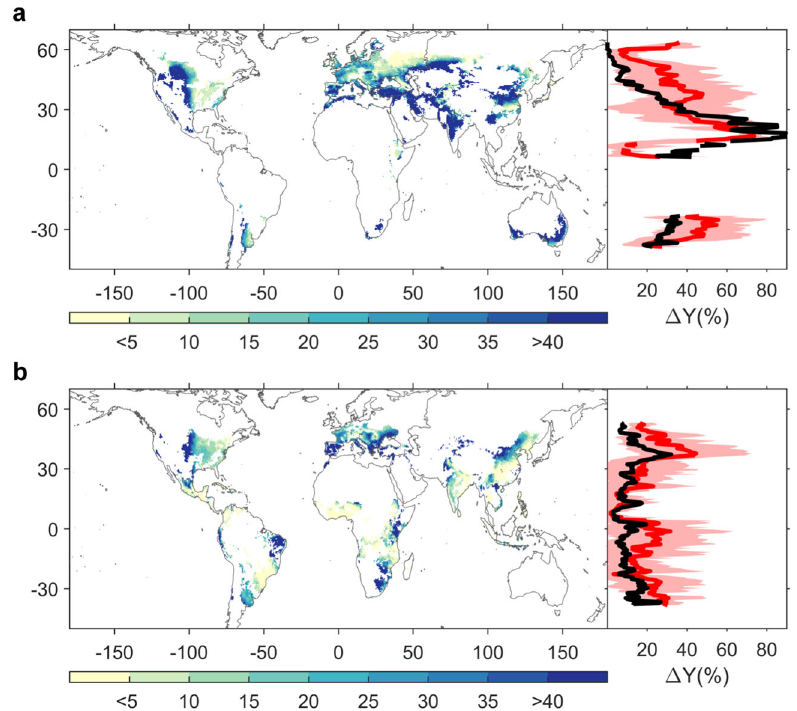
Fig. 2 Spatial and latitudinal changes in Δ Y over contemporary growing area for wheat and maize. a Wheat, b maize. The left panel represents spatial distribution of reanalyzed Δ Y . The right panel shows latitudinal distribution of Δ Y for each one degree latitudinal band. The black curve shows Δ Y estimated from the climate analog (CA) and the red curve shows Δ Y estimated from the reanalysis, with shaded area indicates the range of uncertainty (1 σ standard deviation across models).